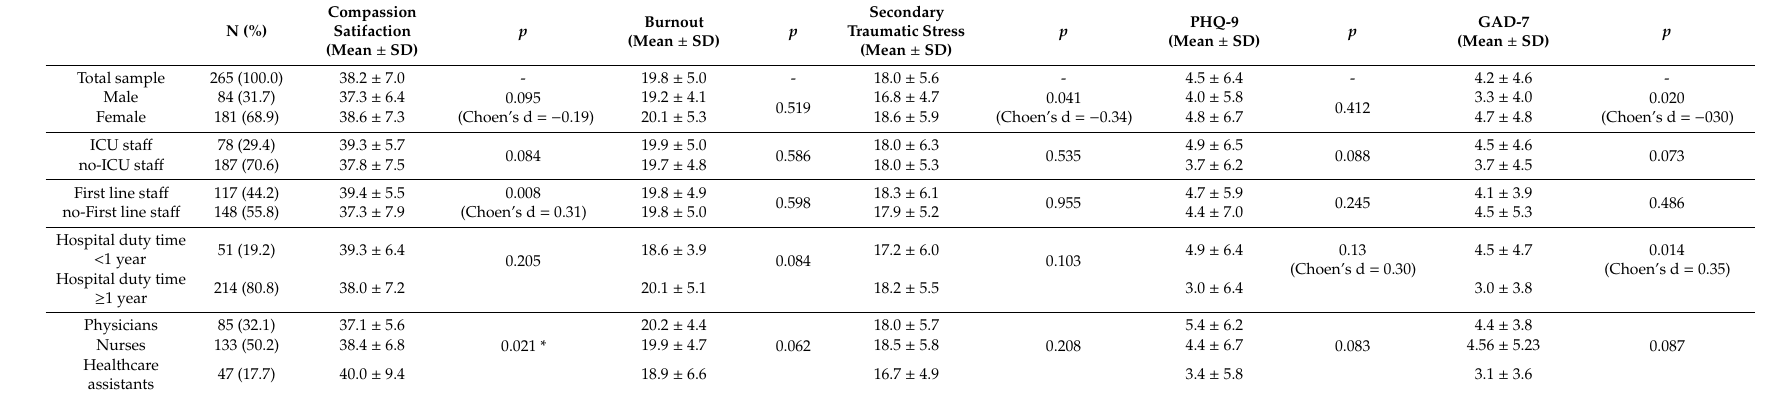
Table 1. Professional Quality of Life Scale version 5 (ProQOL-5) subscales and Patient Health Questionnaire-9 (PHQ-9) and Generalized Anxiety Disorder Seven-Item (GAD-7) scores (mean values ± SD) in the total sample (N = 265) and divided by healthcare workers’ (HCWs’) working and personal